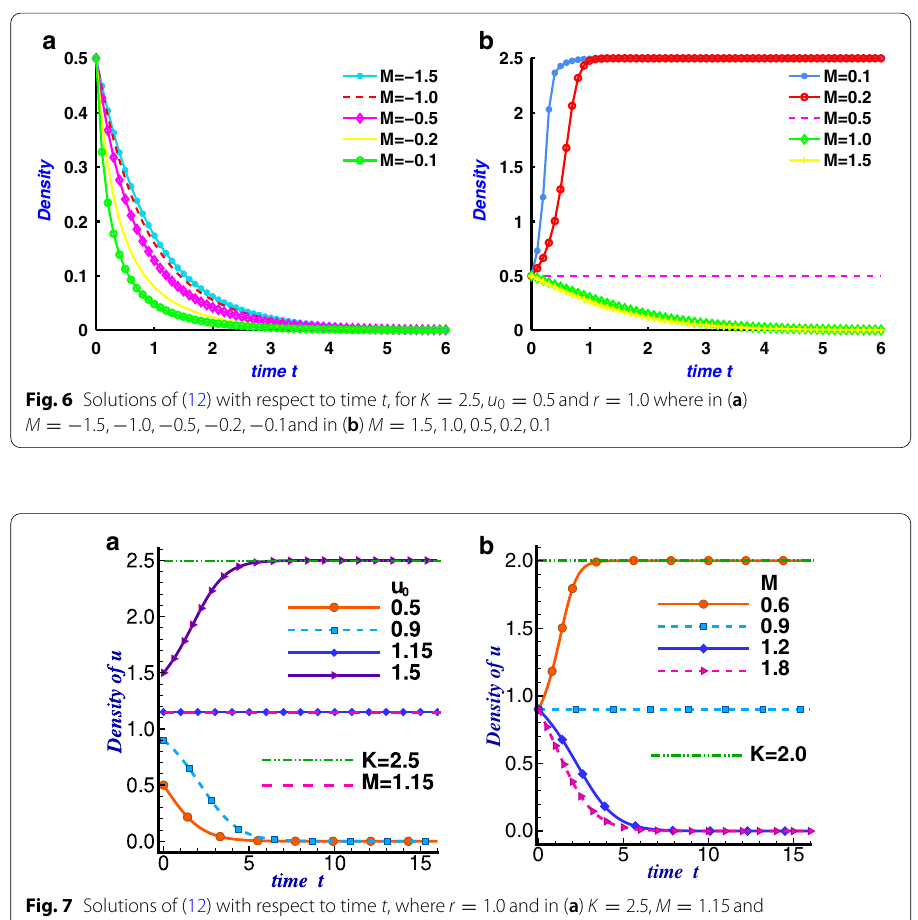
Fig. 7 Solutions of (12) with respect to time t , where r u 0 0.5,0.9,1.15,1.5 and in ( b ) K =